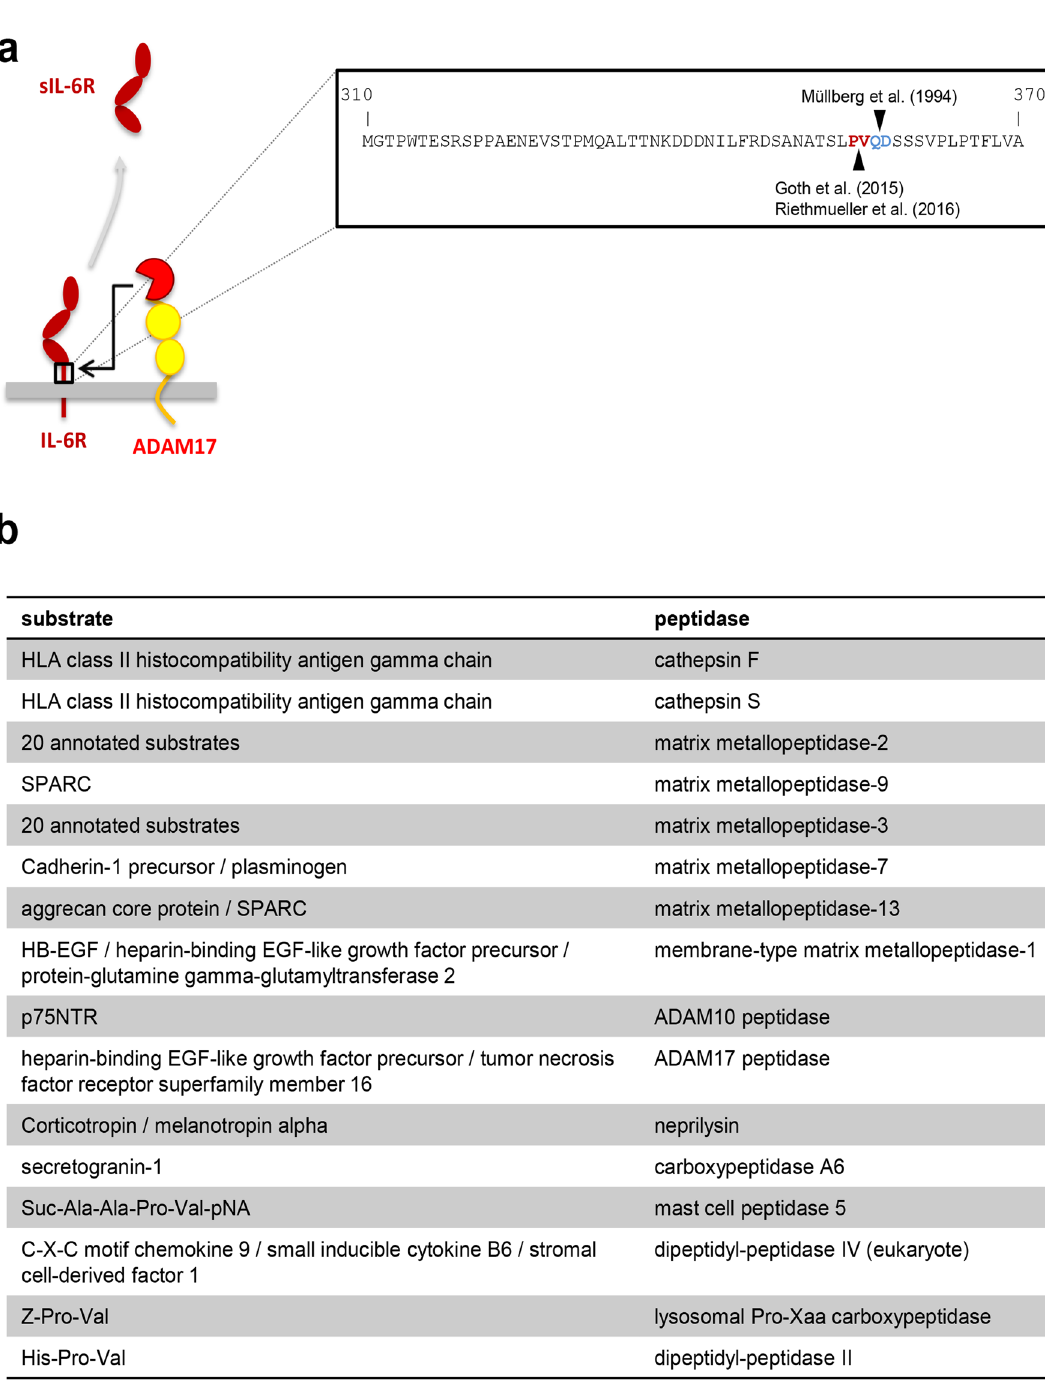
Figure 1. Identification of candidate proteases for IL-6R cleavage based on the cleavage site. (a) Schematic representation of sIL-6R generation via IL-6R proteolysis by ADAM17. The amino acids comprising the stalk region (from Met-310 to Ala-370) are depicted in one letter code in the inset on the right side. Previously described IL-6R cleavage sites attributed to ADAM17 are indicated. (b) Candidate proteases that could cleave the IL-6R between Pro-355 and Ala-356 based on the annotations found in the MEROPS database. For details see Materials and Methods